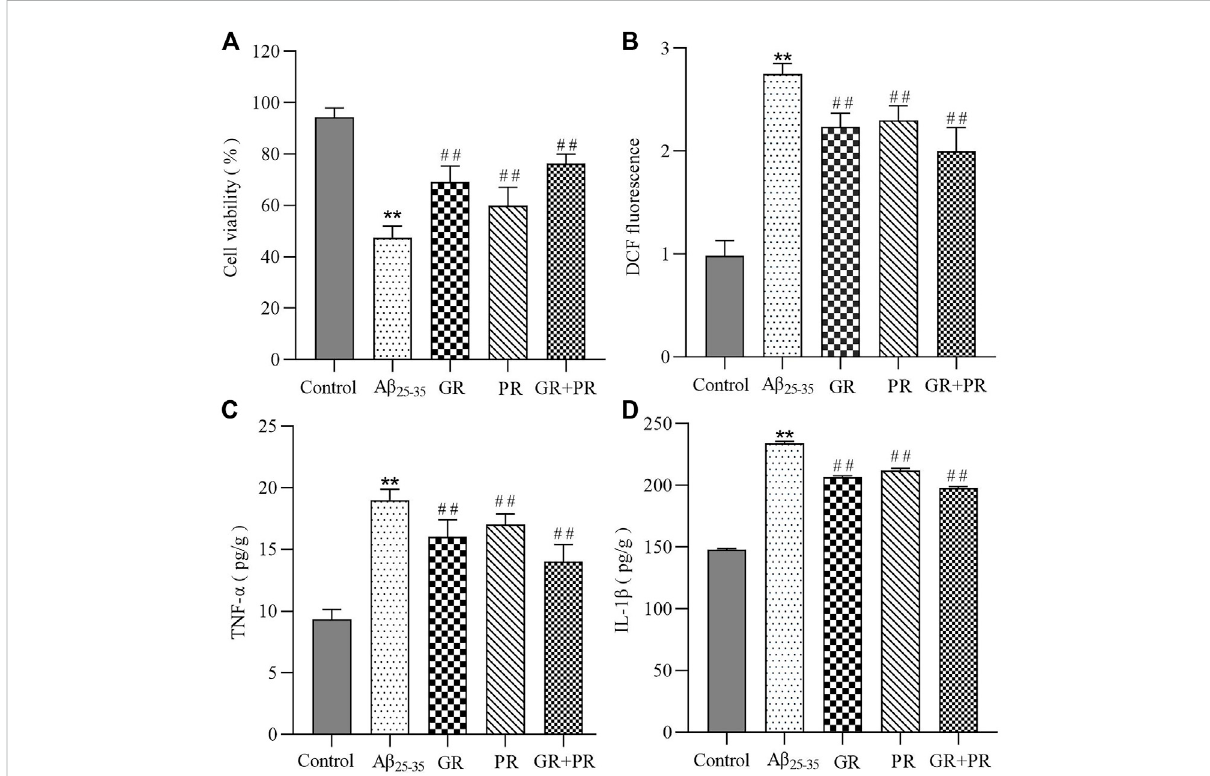
FIGURE 1 In vitro therapeutic ef fi ciency of GR, PR, and GR + PR on A β 25-35 -induced PC12 cells. Cell viability (A) , ROS reduction (B) ,and the inhibition of in fl ammation revealed by an alleviation of TNF- α (C) and IL-1 β (D) on A β 25-35 -induced PC12 cells. Data represent the mean ± SD from six replicates. Compared with the control group, ** p < 0.01. Compared with the A β 25-35 group, ## p <